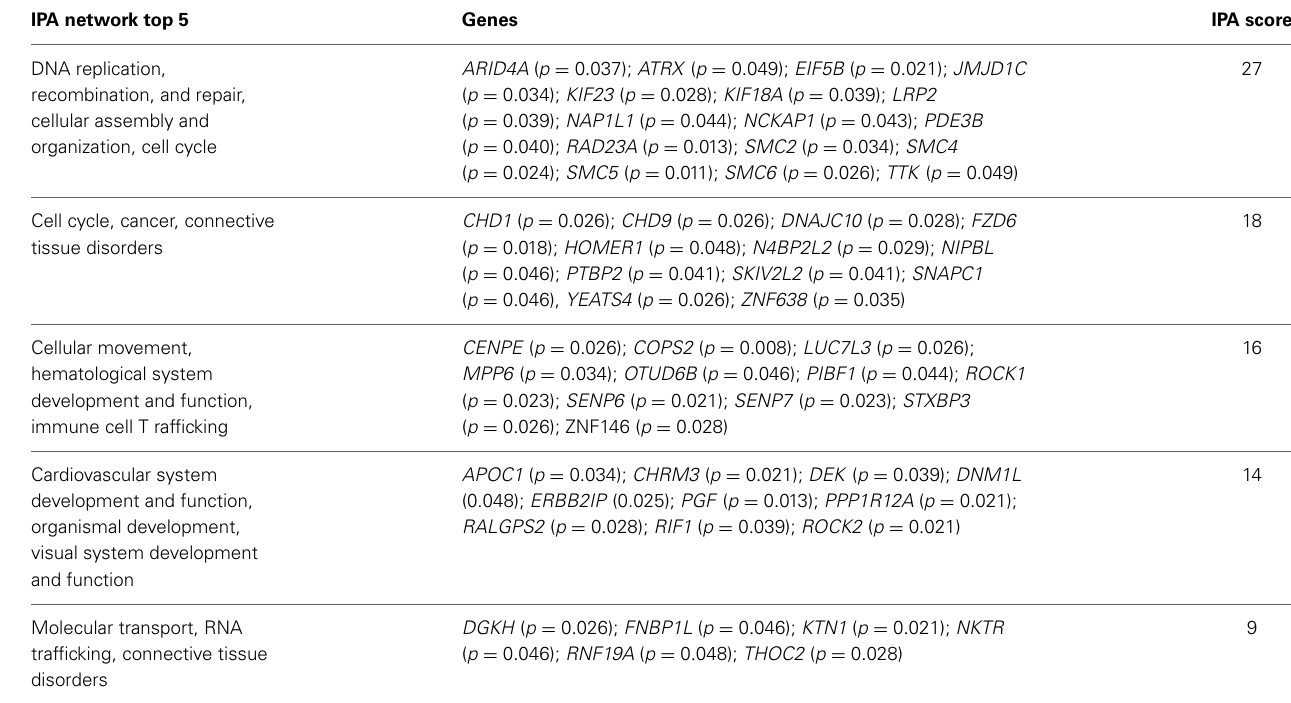
Table 5 | Enriched ingenuity pathway analysis (IPA) categories including differentially expressed genes in the depressed group.